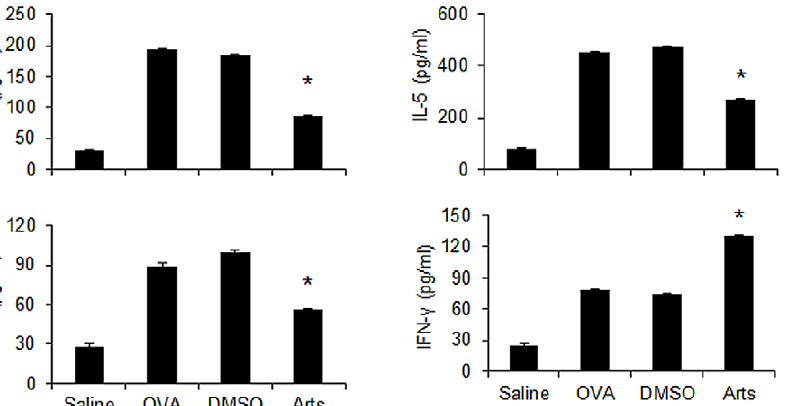
Figure 3. Effects of artesunate on OVA-specific lymphocyte response invitro . Thoracic lymph nodes cells (n=4 mice) were harvested from mice 24 hours after the last OVA or saline aerosol challenge, and cultured for 72 hours with medium alone or OVA (200 m g/ml). The levels of IL-4, IL-5, IL-13 and IFN- c in culture supernatant were determined using ELISA. Values shown are the mean 6 SEM of triplicate cultures of pooled lymph node cell suspensions. *Significant difference from DMSO control, p , 0.05.